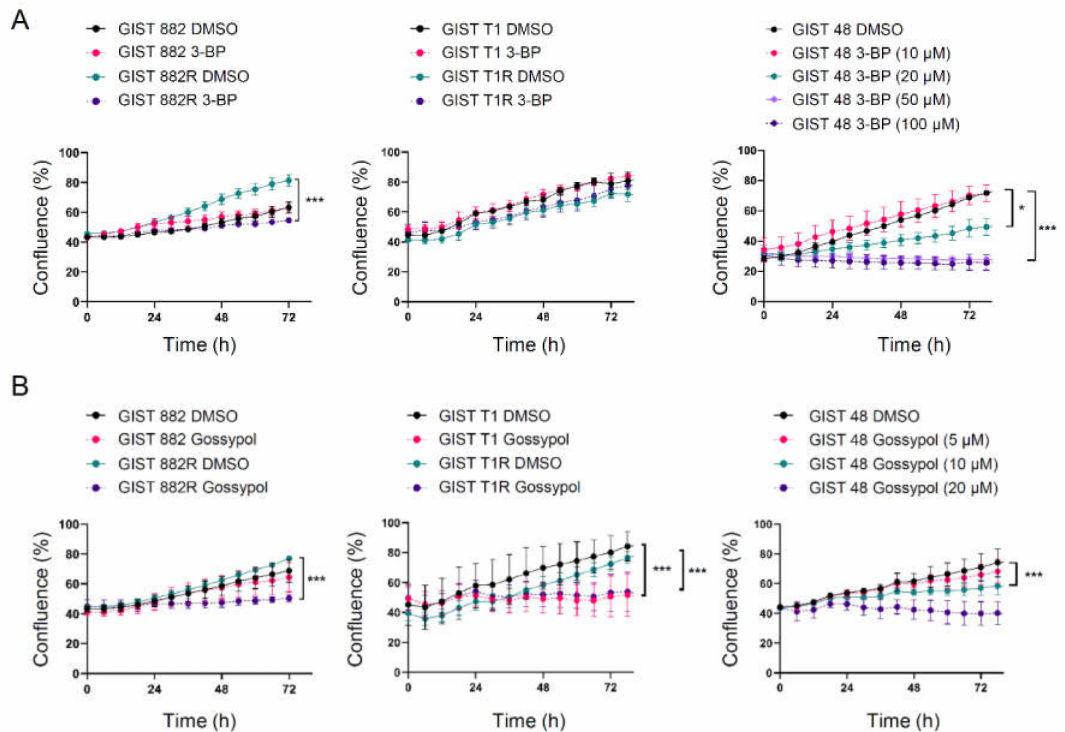
Figure 5. The e ff ect of 3-BP and gossypol on GIST cell proliferation using an Incucyte S3 Live Cell Analysis System. ( A ) The cell confluence (% of occupied area) was measured every 6 h in GIST cells treated with 100 µ M of 3-BP or DMSO. GIST 48 cells were treated with 3-BP at various concentrations or DMSO. * p < 0.05, *** p < 0.001 (Student’s t -test or 2-way ANOVA with Dunnett’s test, n = 3). ( B )